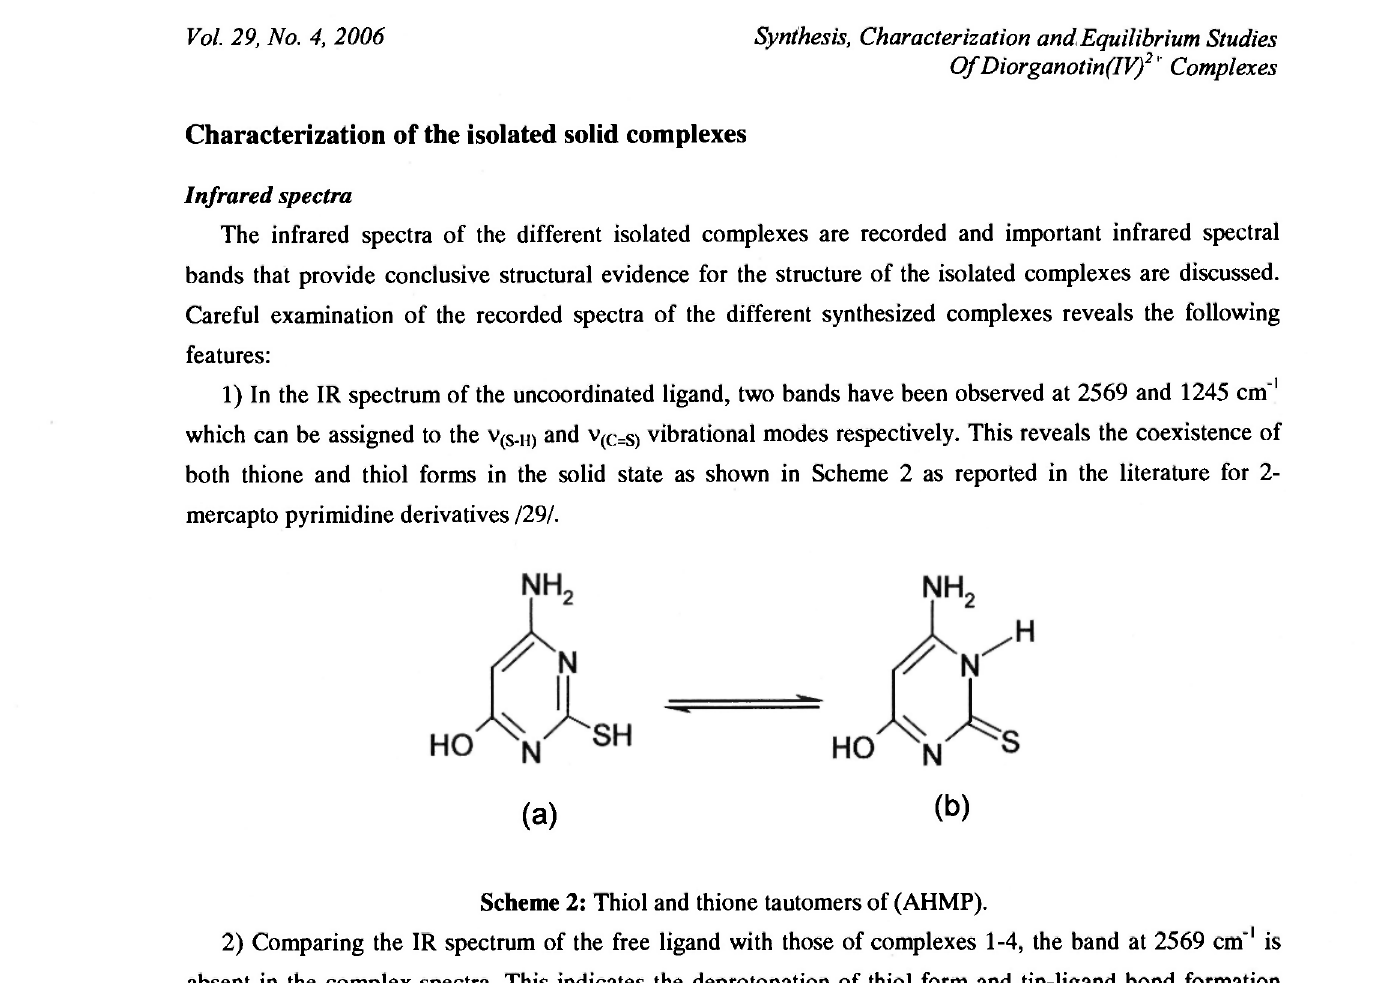
Scheme 2: Thiol and thione tautomers of